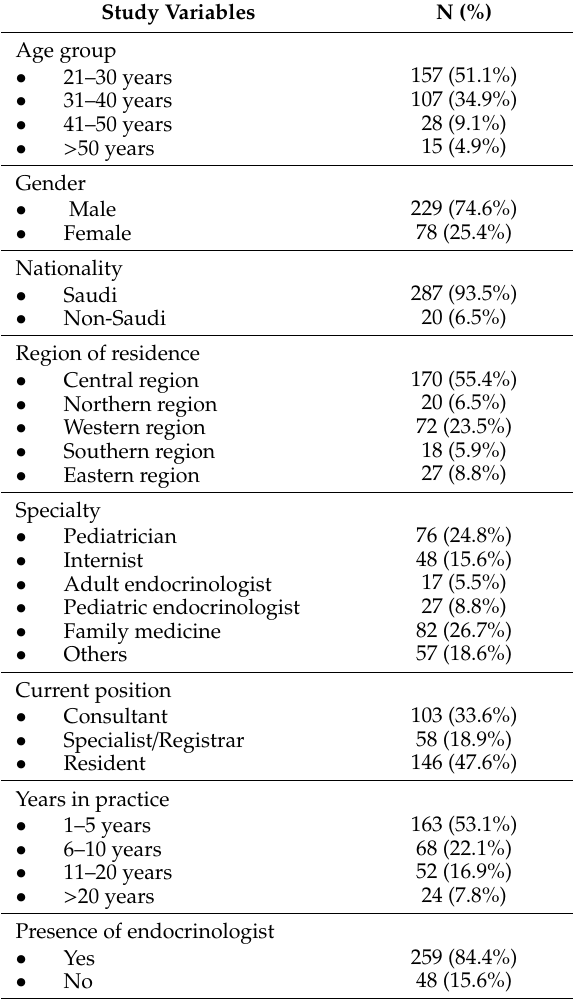
Table 1. Sociodemographic characteristics of physicians (n =